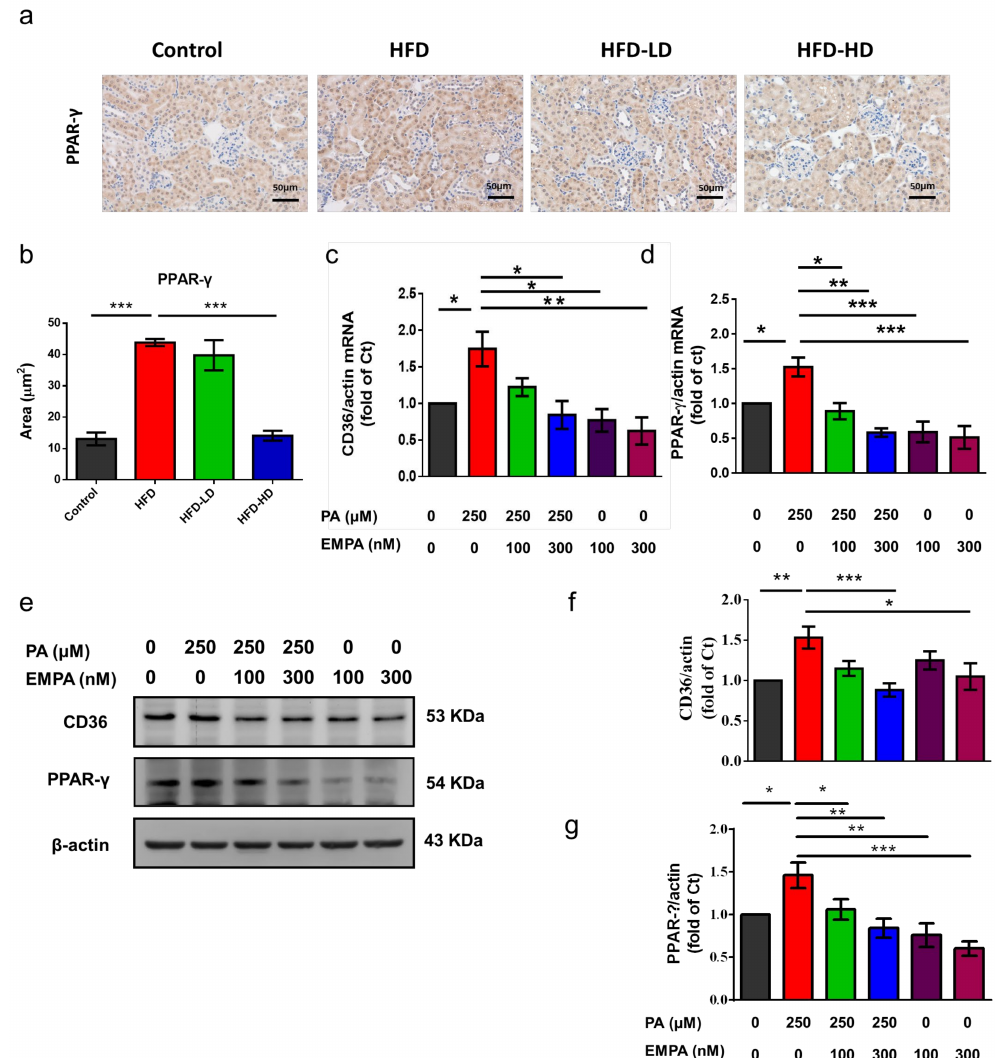
Figure 6. Empagliflozin treatment downregulates PPAR- γ expression in the kidney of HFD-fed mice and PA-treated HK-2 cells. ( a , b ) In the mouse kidney, high-dose empagliflozin attenuates PPAR- γ expression, as shown by immunohistochemical staining. ( c ) HK-2 cells were cultured in medium with 1% bovine serum albumin, PA (250 µ M), and low-dose (100 nM) or high-dose (300 nM) empagliflozin. High-dose empagliflozin significantly reduces the expression levels of CD36 mRNA ( c ) and protein ( e , f ). Empagliflozin also reduces PPAR- γ mRNA ( d ) and protein expression ( e , g ). The histograms represent mean ± standard error (SE) from 6 experiments. Statistical analysis was performed with one-way ANOVA. * p < 0.05, ** p < 0.01, *** p < 0.001. EMPA, empagliflozin; PA, palmitic acid; PPAR, peroxisome proliferator-activated